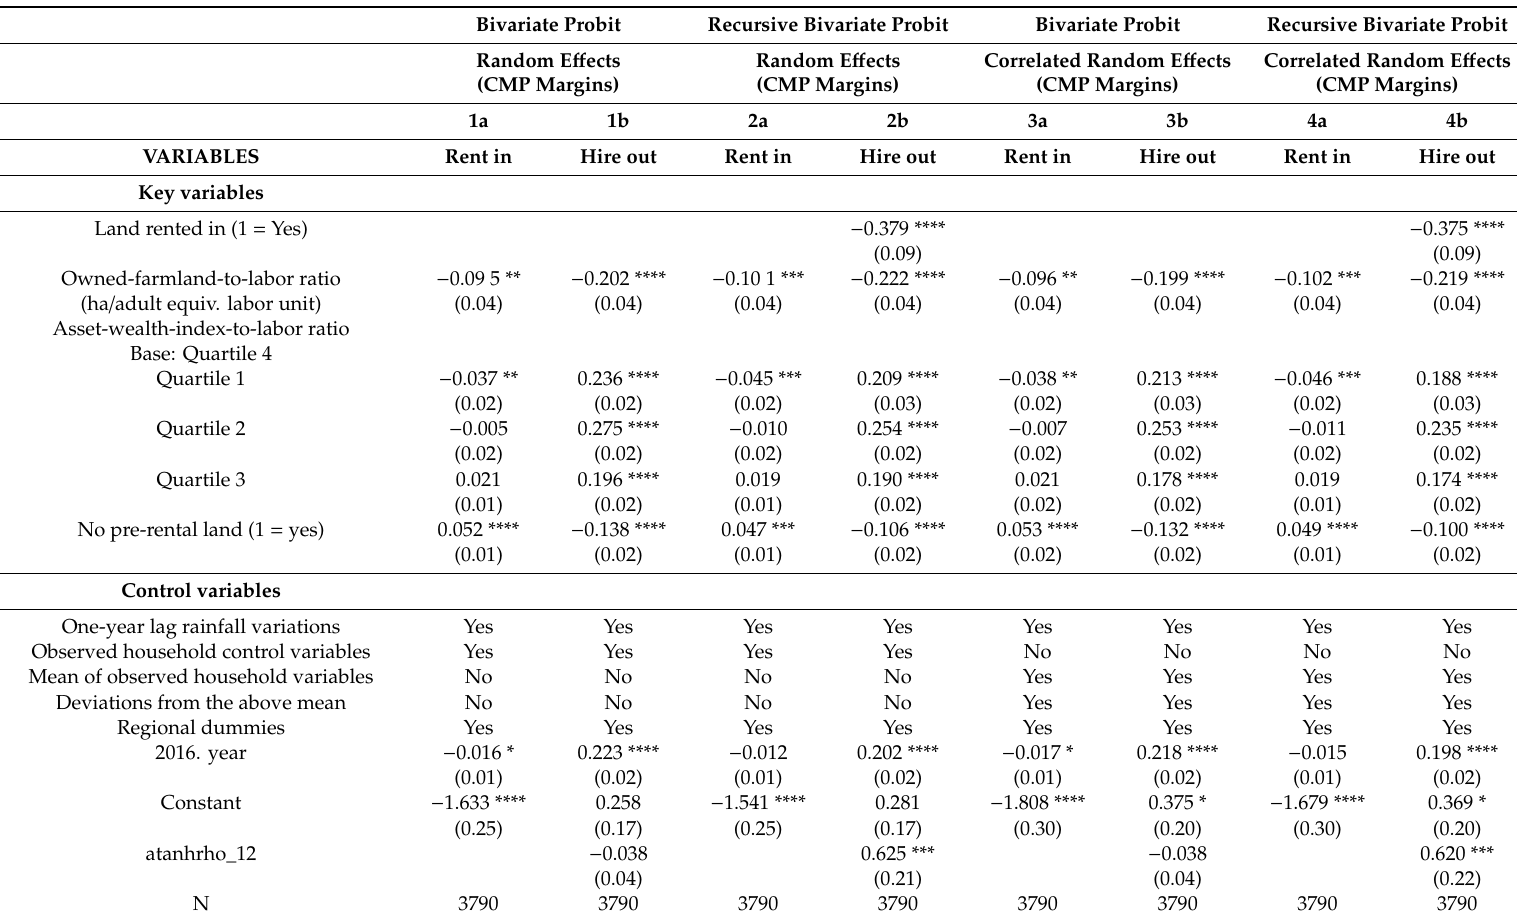
Table 3. Bivariate probit model with conditional mixed process (CMP) margins for land rental and casual labor ( ganyu ) market participation. Bivariate